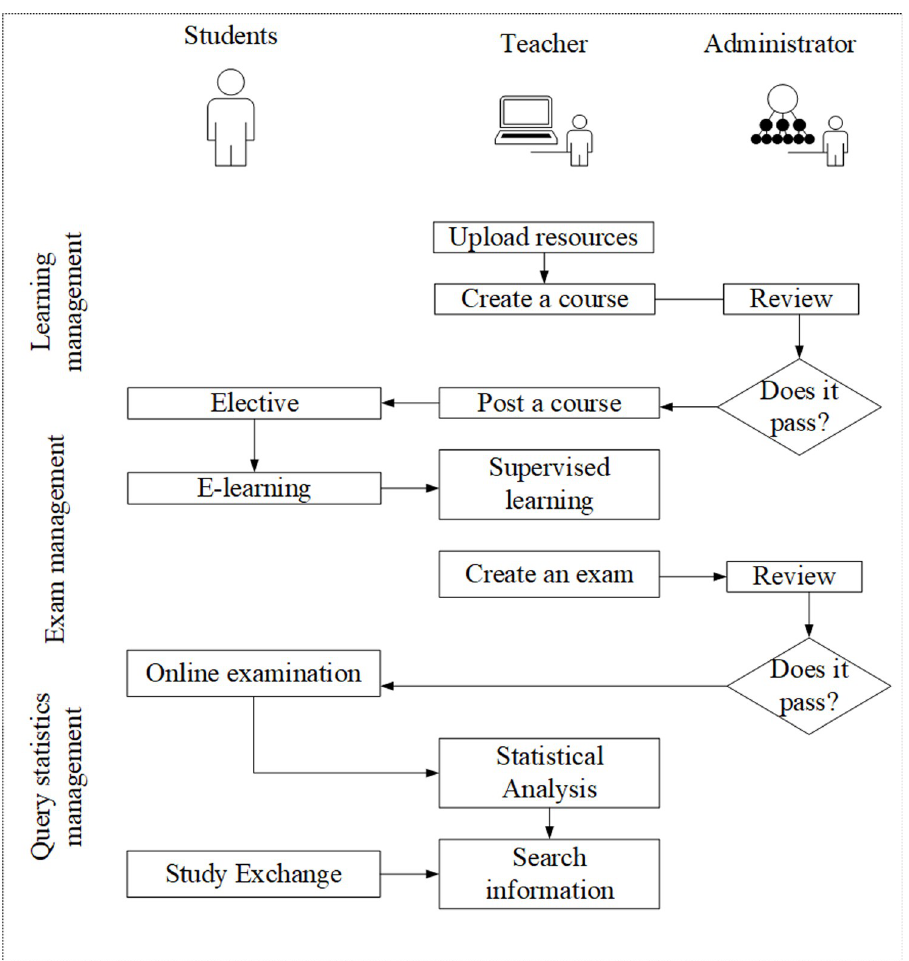
Fig 1. The process of system construction requirements of all